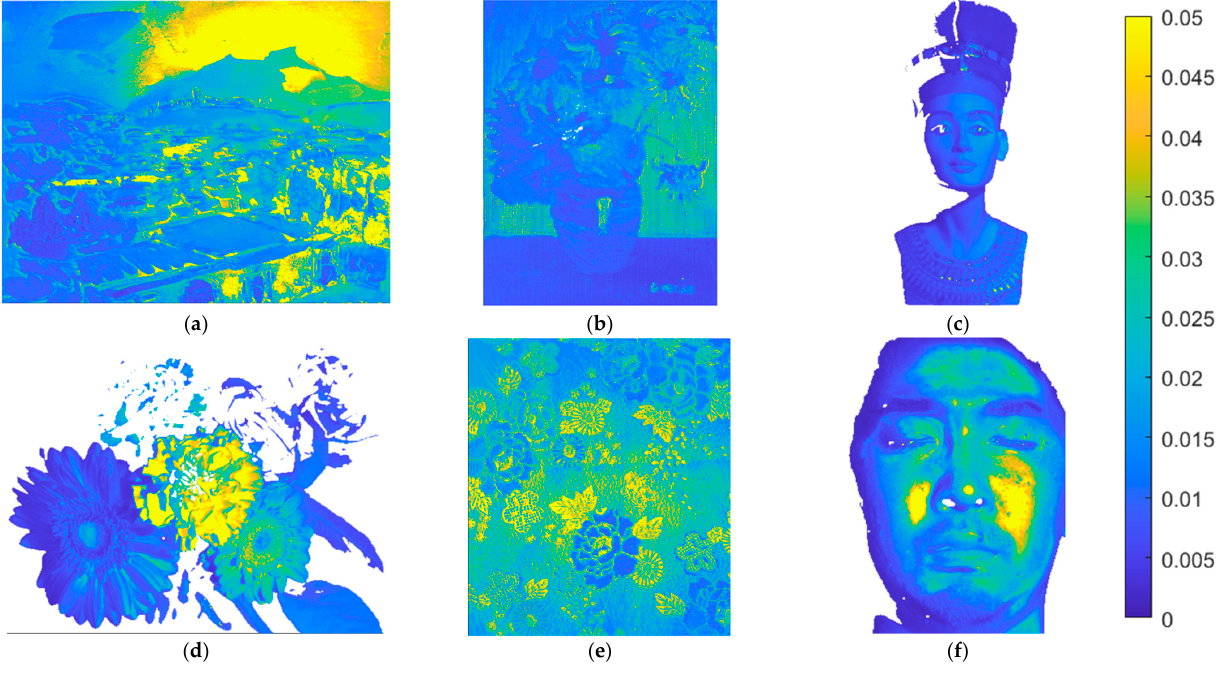
Figure 17. ( a – f ) showing the E Ref maps for the test images in Figure 15a–f, respectively, using the II-wPCA method and RGBF camera. Pixel E Ref values greater than 0.05 are set to 0.05. Using the II-LUT method and RGBF camera, Figure 18a–f show the ∆ E 00 maps for the test images in Figure 15a–f, respectively. Pixel ∆ E 00 values greater than 5.0 are set to 5.0. Figure 19a–f are the same as Figure 18a–f, respectively, except that the II-wPCA method was used. For the ∆ E 00 maps of the “watercolors” and “cloth” images, using the